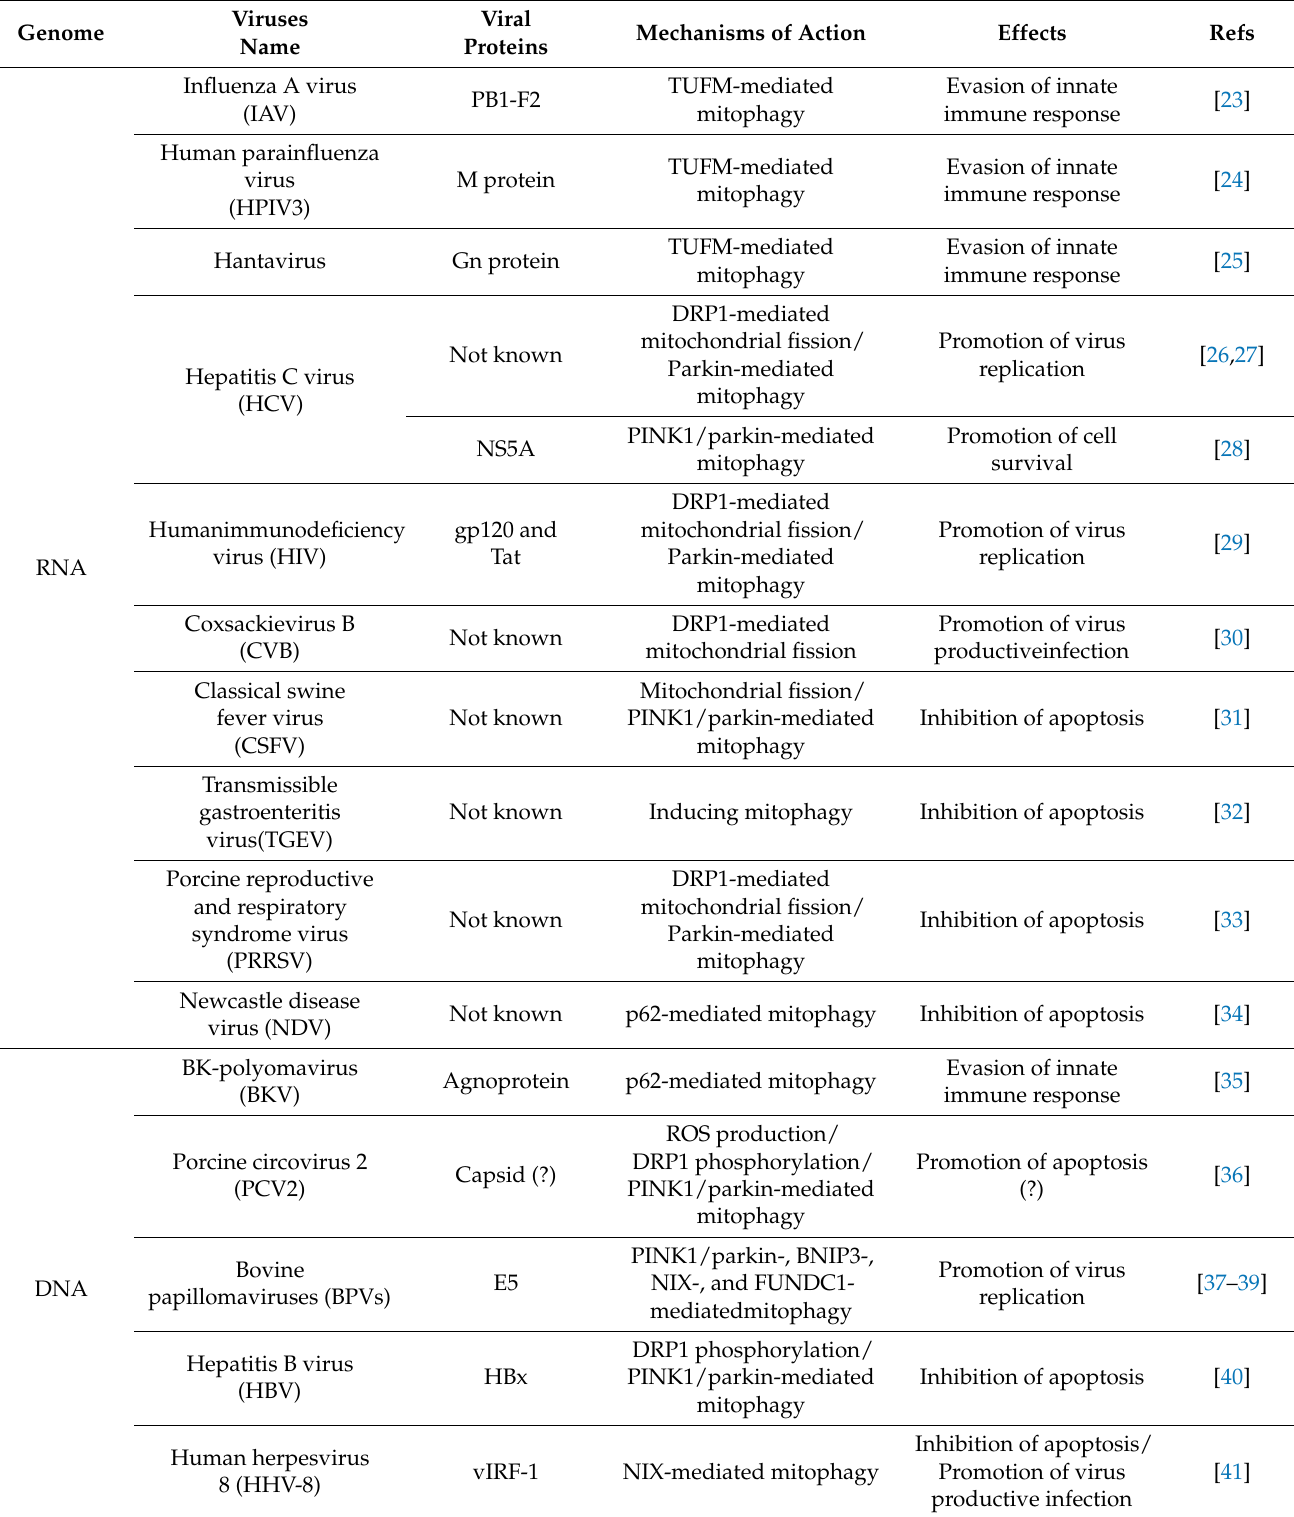
Table 2. Viral regulation of mitochondrial dynamics and